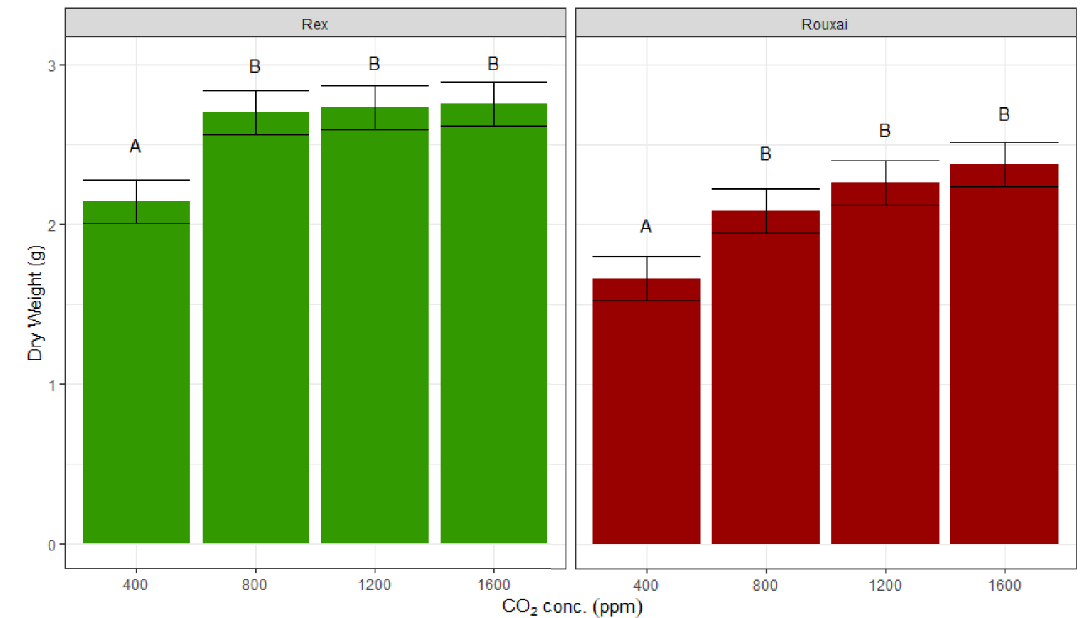
Figure 4. Dry weight biomass of lettuce ‘Rex’ and ‘Rouxai’ after 21 days in response to CO 2 concentration. Data represent estimated marginal means and standard error as calculated by five plants per cultivar in each of four replicate crop cycles in a complete randomized block design. Letters represent mean separation comparison using Tukey’s Honestly Significant Difference (alpha = 0.05).